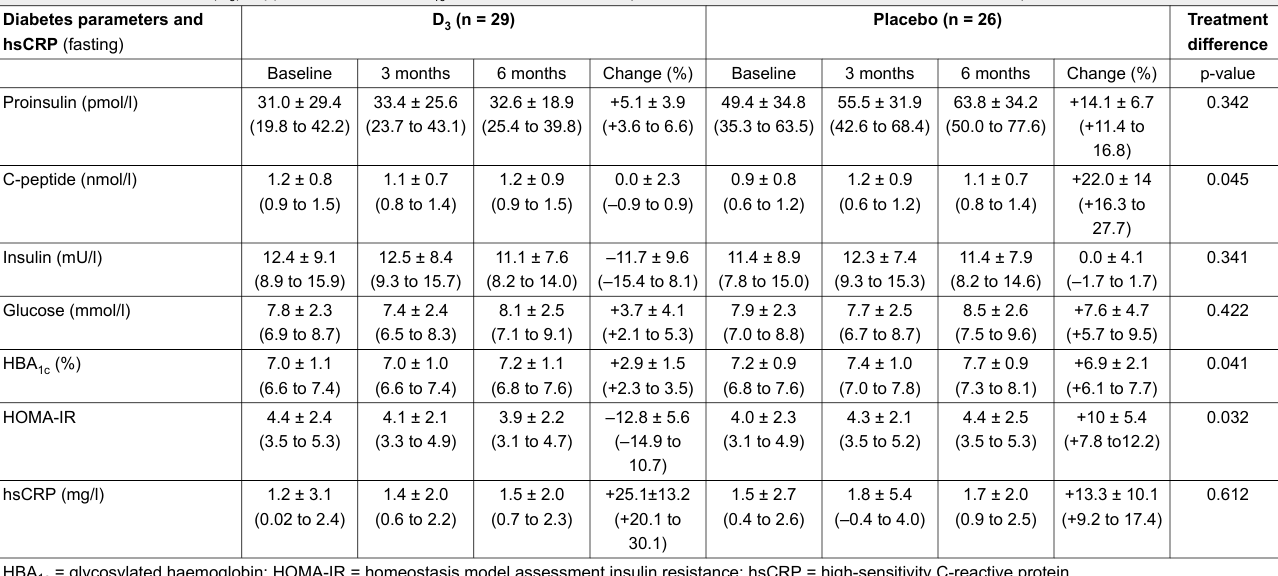
Table 3: Effect of vitamin D (D 3 ) supplementation on calci-/phosphotropic hormones (mean ± standard deviation, 95% confidence interval). Calci-/phosphotropic hormones